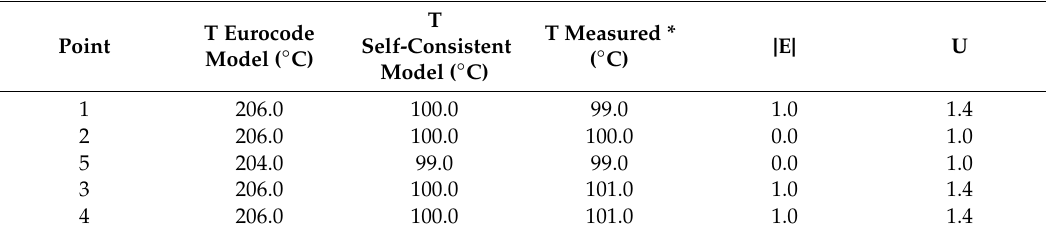
Table 2. Comparison between modelled—using, respectively, Eurocode and self-consistent convection coe ffi cient—and measured temperatures; error estimation and validation of the self-consistent model.